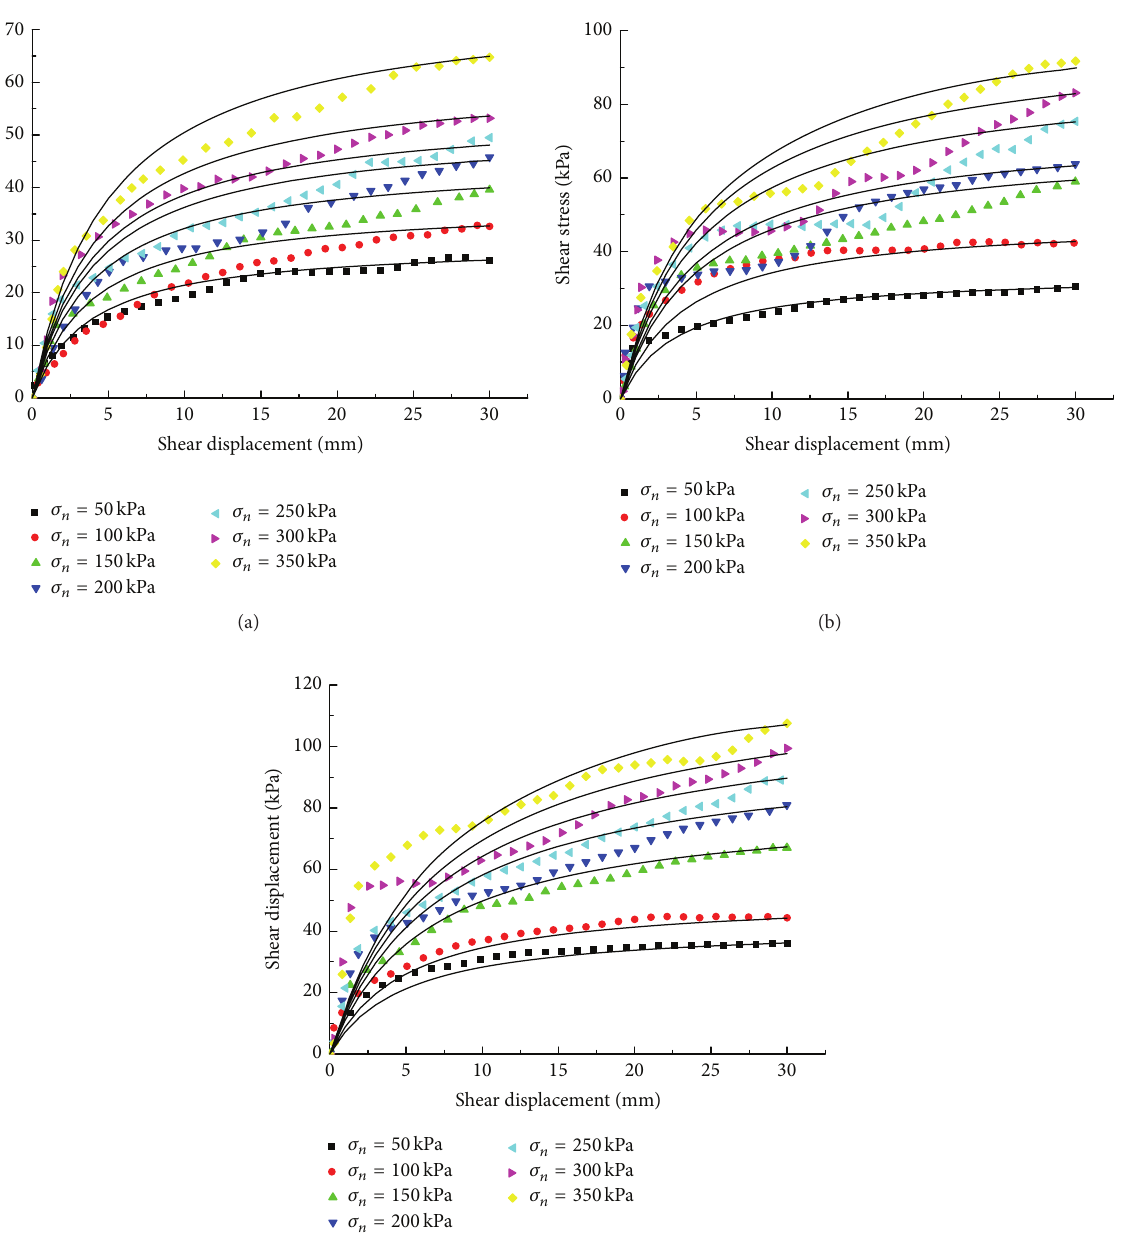
rougher interface offers a higher shear stress and vertical